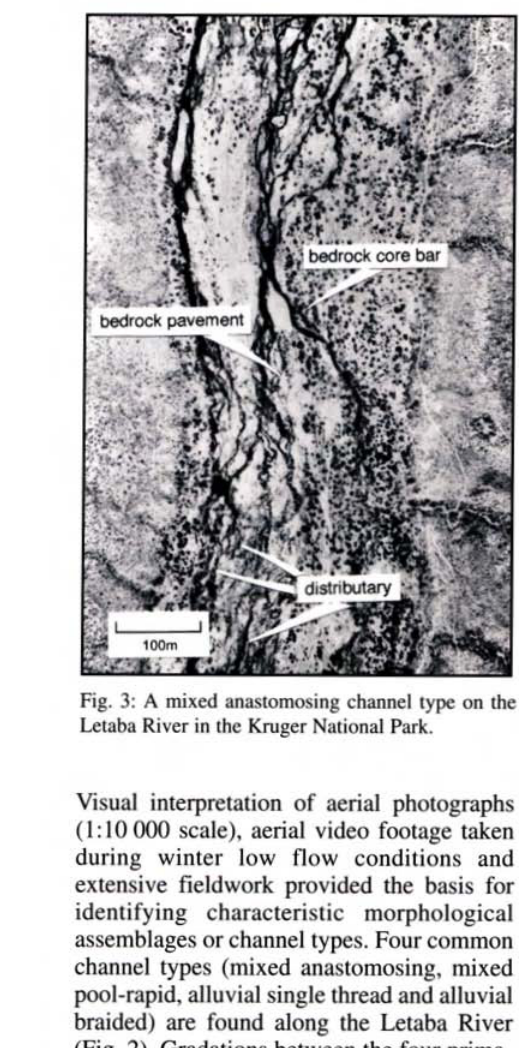
Fig. 3: A mixed anastomosing channel type on the: Letaba River in ihe Kruger National